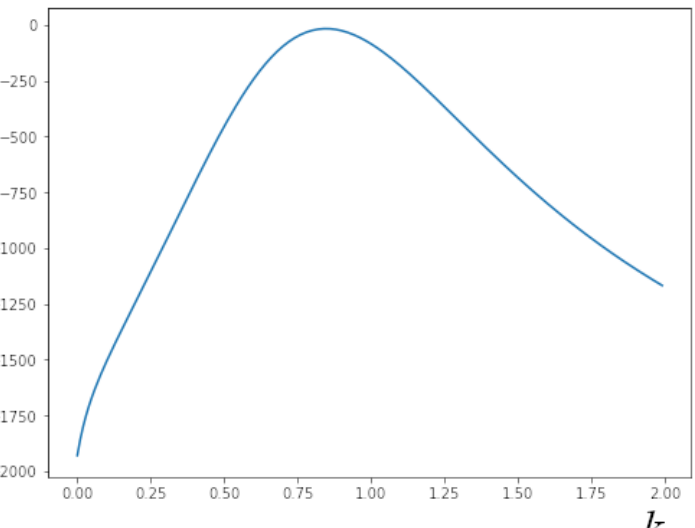
Figure 13. An example of logarithm posterior distribution for model parameter k in describing the √ s = 2.36TeV. The maximum is reached at k = 0.85. multiplicity distribution in pp collisions at